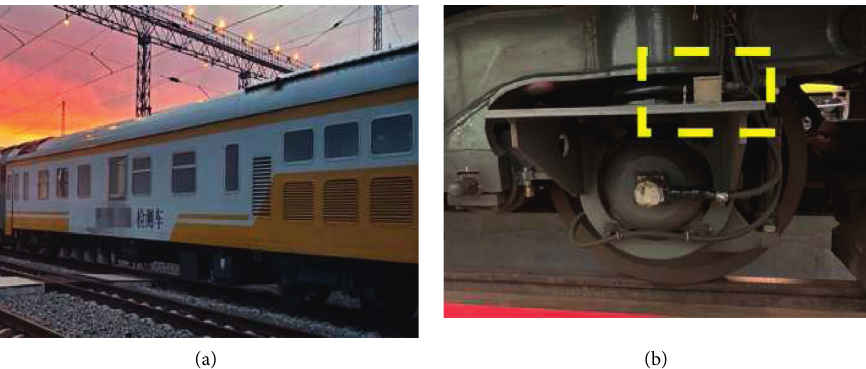
Figure 5: Photo of the inspection train and the sensor location. (a) The heavy-haul railway comprehensive inspection train. (b) The installed location of the axle-box acceleration